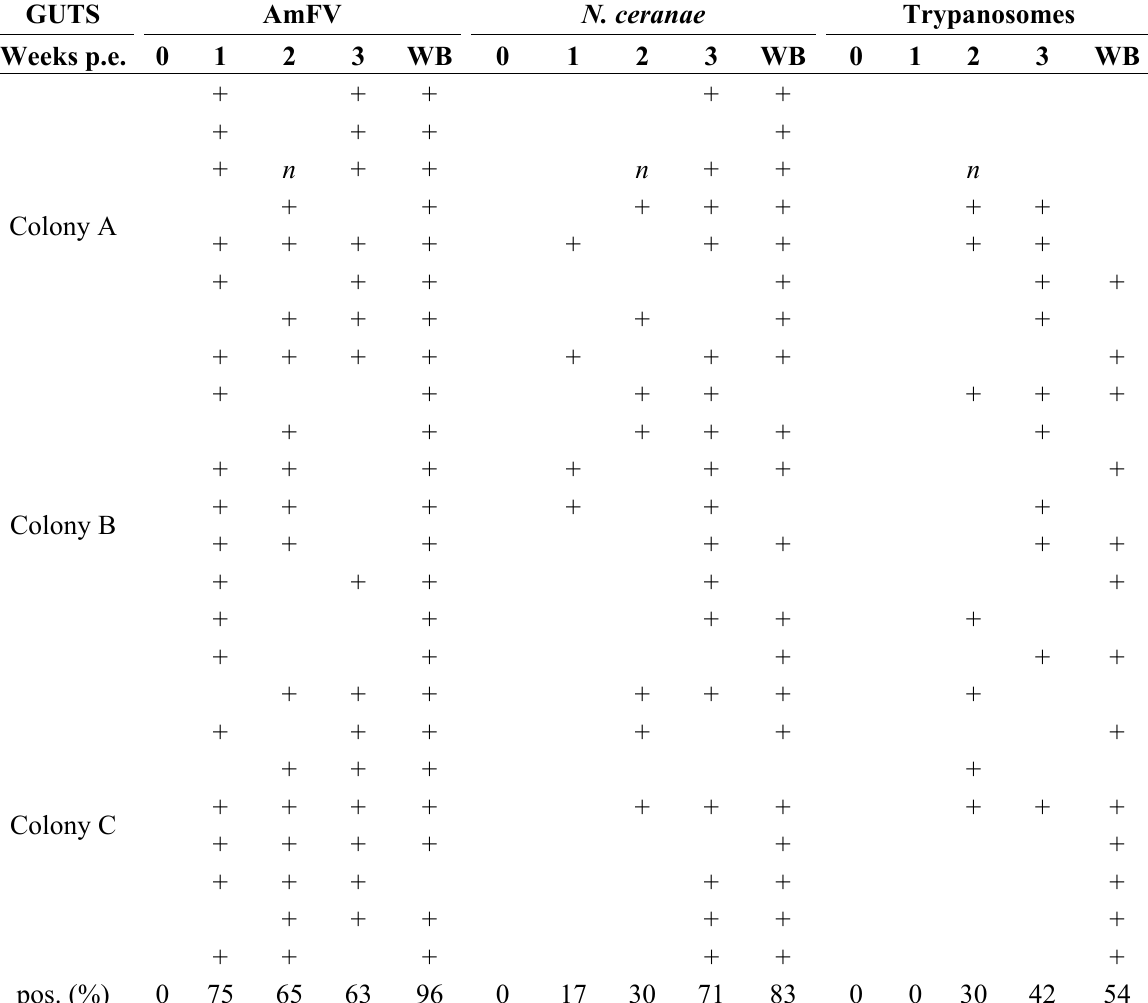
Table 1. Detection of Apis mellifera Filamentous virus (AmFV), Nosema ceranae and C. mellificae/L. passim from individual bees at 0, 1, 2 or 3 weeks after emergence (weeks p.e.) and in winter bees (WB) ( n = 24 workers from 3 colonies). +: Percentage of PCR positive intestines. n : Samples not analyzed due to failed DNA